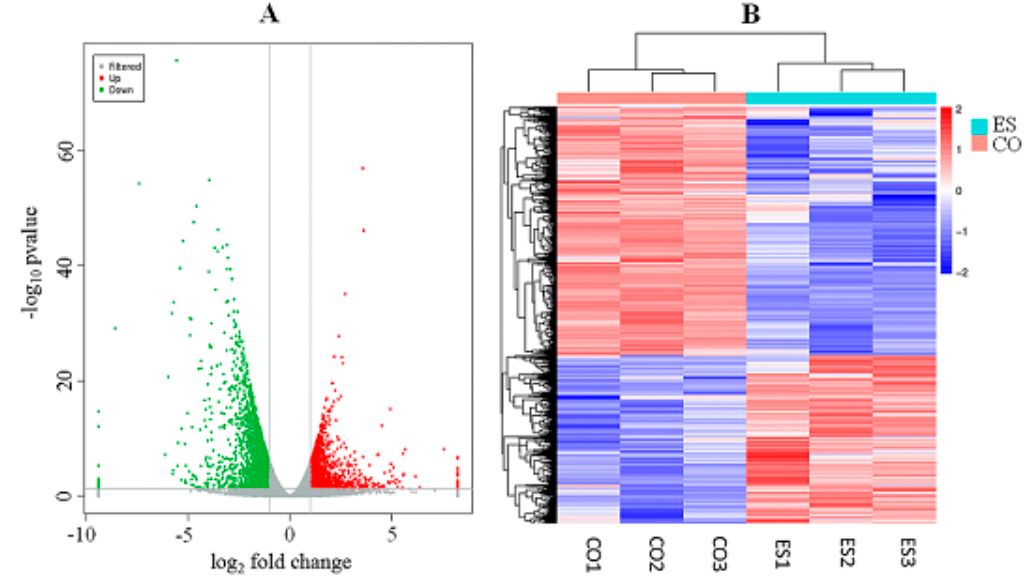
Figure 1. ( A ) Volcano plot of the total expression of genes in the subcutaneous fat of the yaks in the ES and CO groups. ( B ) Hierarchical clustering analysis of the transcriptome profiles in the subcutaneous fat of the yaks in the ES and CO groups.